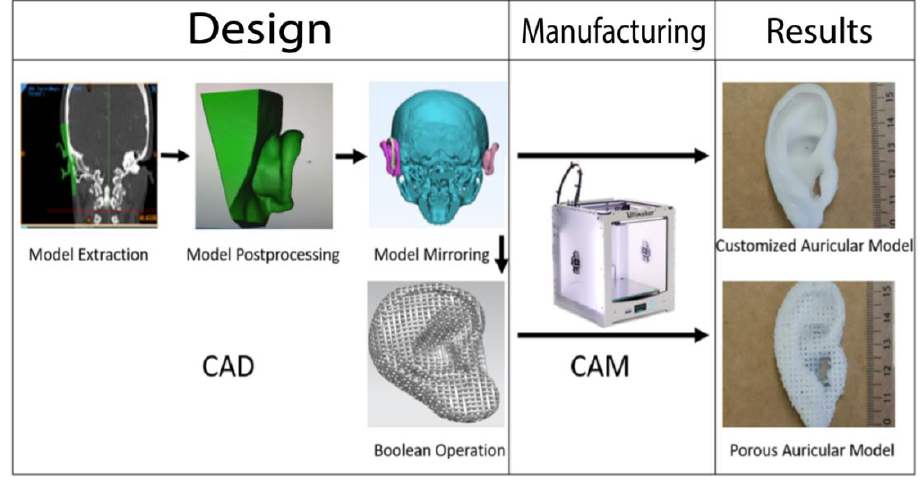
Figure 1. Summary of the workflow of the design and manufacturing process of the patient-customized solid and porous auricular constructs. During input phase, the unaffected ear (displayed in green) of a female patient was extracted and edited (postprocessing). The final model was mirrored with AutoCAD on a skull model, and a Boolean operation was used to design pores into the auricular construct before processing the final output with the Ultimaker 2+. The process was repeated for all three filament materials.